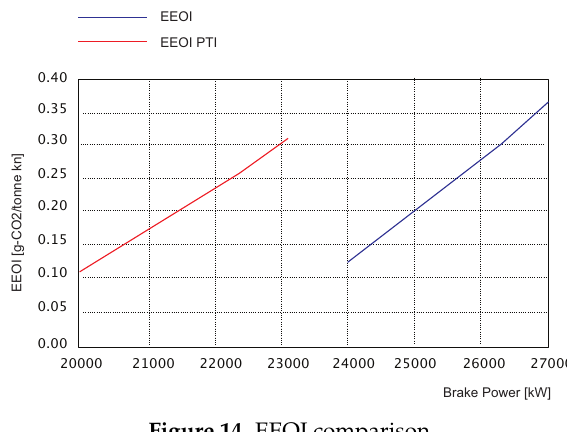
Figure 14. EEOI comparison.